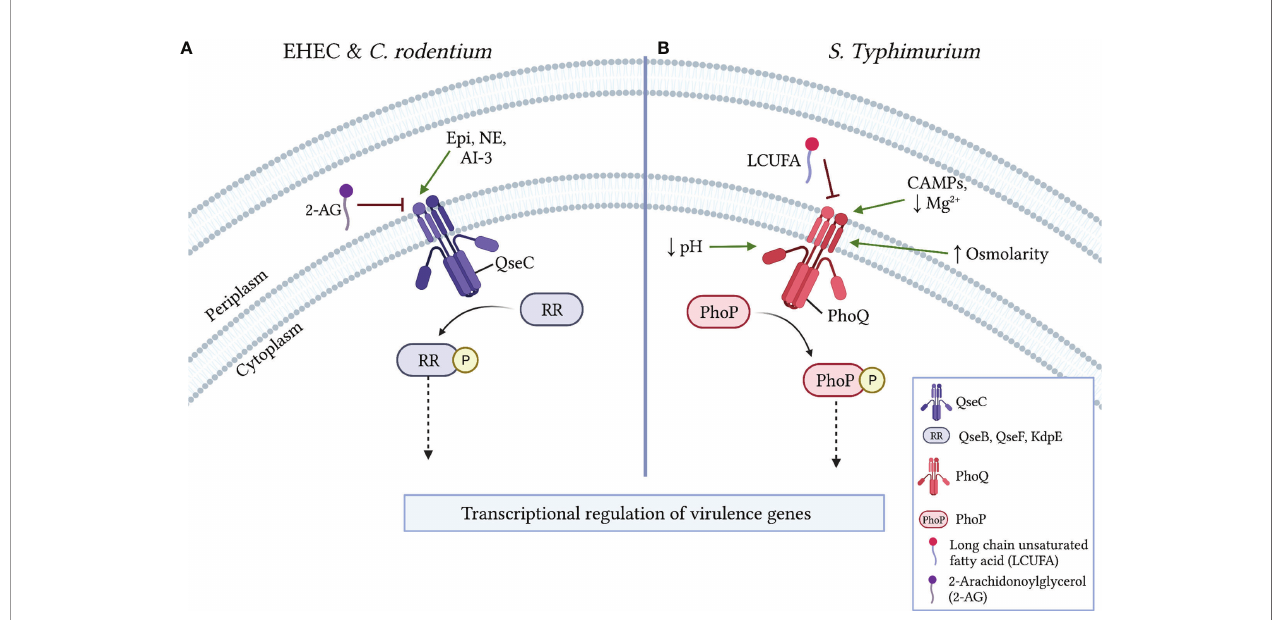
FIGURE 2 | Mechanisms of virulence regulation via LCFA sensing by histidine kinase receptors. (A) In EHEC and C. rodentium , the activation of the pro-virulence histidine kinase receptor QseC is either induced by epinephrine (Epi), norepinephrine (NE), or autoinducer 3 (AI-3) or inhibited by 2-arachidonylglycerol (2-AG). Following its activation, QseC phosphorylates the response regulators (RR) QseB, QseF, and/or KdpE, resulting in the downstream transcriptional regulation of virulence genes. (B) In S. Typhimurium, the histidine kinase receptor PhoQ is inhibited by LCUFAs or activated in the periplasm by low Mg 2+ , other divalent cations, or the presence of cationic antimicrobial peptides (CAMPs). PhoQ is also activated by low cytoplasmic pH (~5) or by osmotic stress. Following its activation, PhoQ phosphorylates the RR PhoP, which results in the downstream transcriptional regulation of virulence